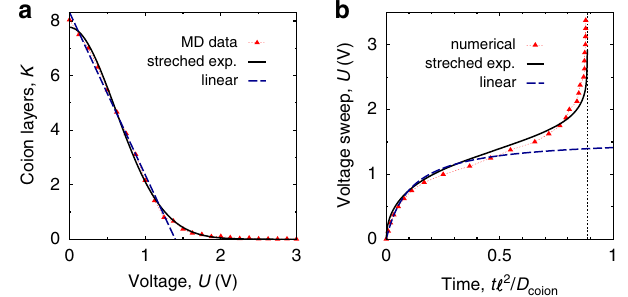
Fig. 2 Determination of non-linear sweep function. a Number of co-ion layers in a nanopore, K , as a function of potential U applied to the pore with respect to the bulk electrolyte. Symbols denote the values obtained from MD simulations of a model supercapacitor (Fig. 1d). K was calculated as K = ρ w ℓ a = N a / h , where ρ = N w ℓ h ) and N c c c c /( c are the density and the number of co-ions in a pore, respectively, a is the ion diameter, and w , ℓ , and h are the width, length, and height of the pore; K 0 is the value of K at U = 0 V. The solid and dashed lines are approximations to these data by stretched exponential (eq. (3)) and linear (eq. (7)) functions, respectively. The ion diameter a = 0.5 nm, the pore width w = 0.6 nm and the pore length ℓ = 12 nm; for other pore lengths see Supplementary Figs. S5 and S6, and for the fi tting parameters see Fig. S7. b Non-linear voltage sweeps as obtained by numerically integrating eq. (2) with the MD data for K ( U ) from a and by using the stretch exponential and linear approximations for K ( U ); the corresponding non-linear sweep functions are given by eqs. (6) and (9), respectively. The thin dotted line shows t = τ , where U ( t ) diverges, see eqs. (5) and